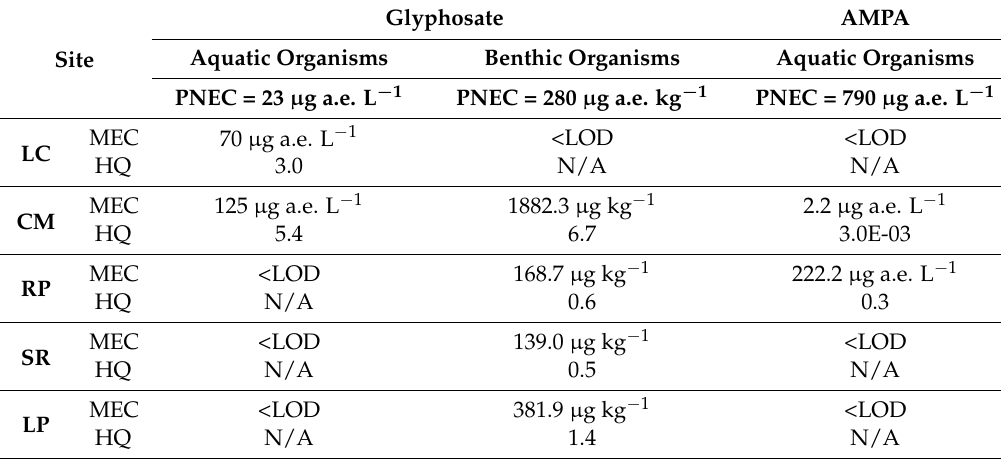
Table 4. Hazard quotient (HQ) of glyphosate and aminomethylphosphonic acid (AMPA) in water and sediments of the Suqu í a River